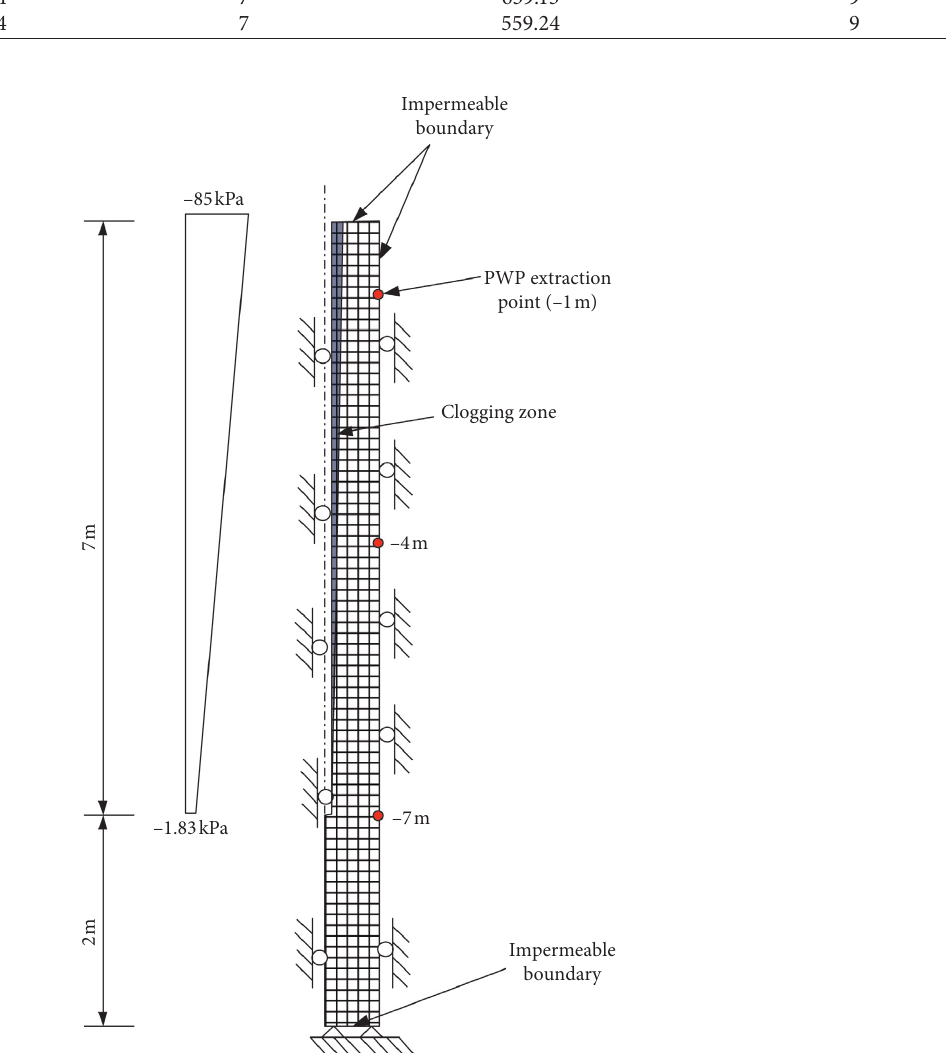
Figure 12: Finite-element mesh. Table 5: Material